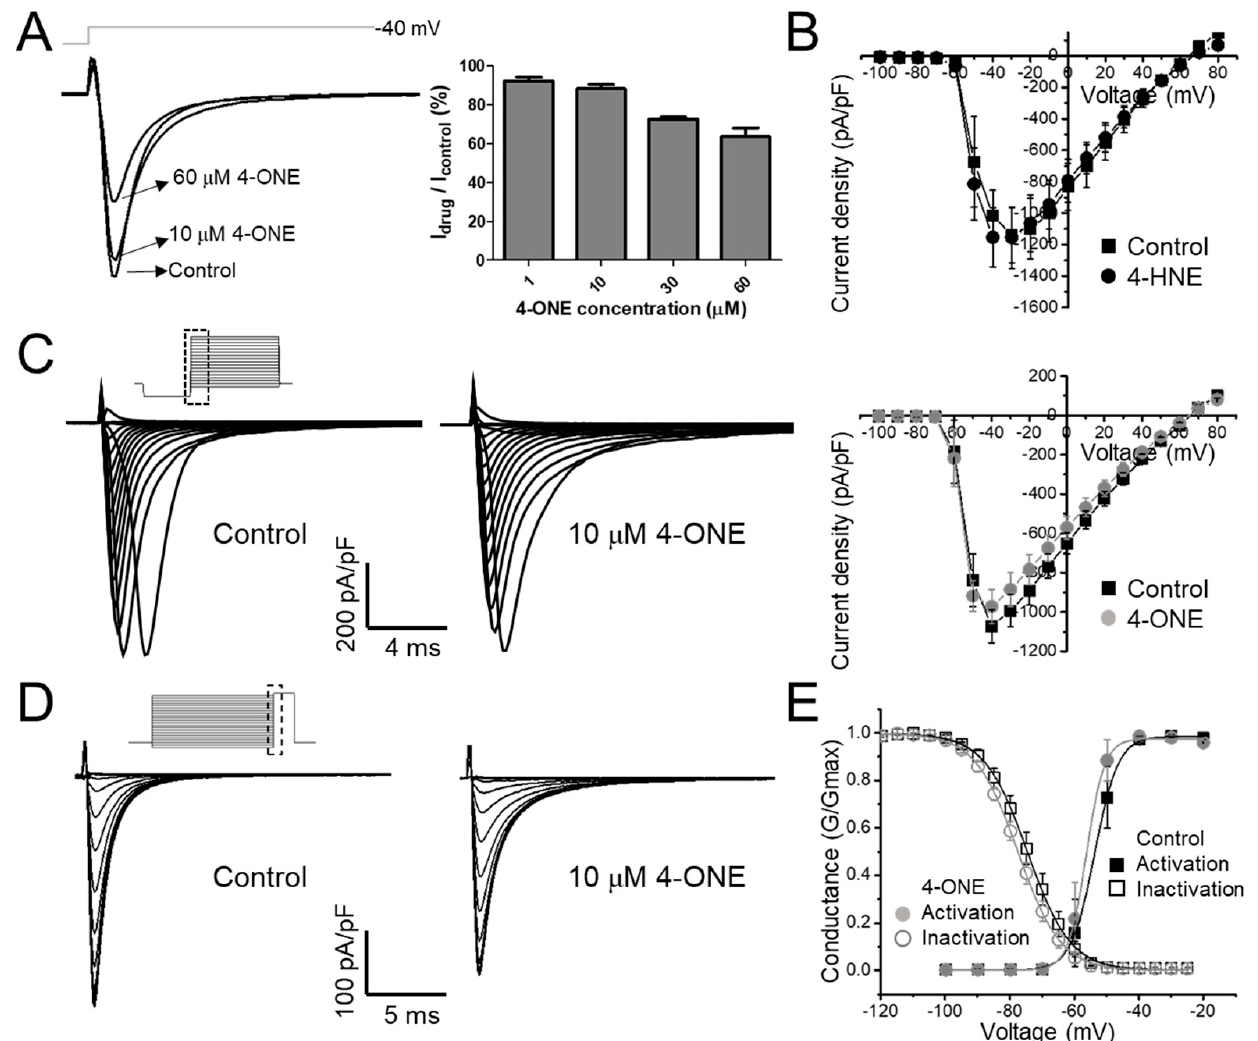
Figure 1. The modulations of hNa V 1.5 channel by 4-oxo-nonenal (4-ONE) were evaluated in HEK-293 cell line cells stably overexpressing hNa V 1.5 (hNa V 1.5-HEK cell). ( A ) The Na V 1.5 current (I NaV ) was activated by applying a depolarization pulse to − 40 mV from − 120 mV of hyperpolarized potential. ( B , C ) The current–voltage (I–V) relationship was analyzed by applying multistep depolarization pulse protocol from − 100 to 80 mV from − 120 mV of hyperpolarization for 200 ms. ( B ) I–V relationship for control and 100 µ M 4-hydroxy-nonenal (4-HNE)-treated I NaV . ( C ) Raw traces and I–V relationship of I NaV for control and 10 µ M 4-ONE. ( D ) Steady-state inactivation of I NaV was analyzed at − 20 mV by applying 200 ms of pre-inactivating voltages from − 120 to − 25 mV. ( E ) Relative conductance of inactivation and activation voltage dependences was analyzed by 10 µ M 4-ONE